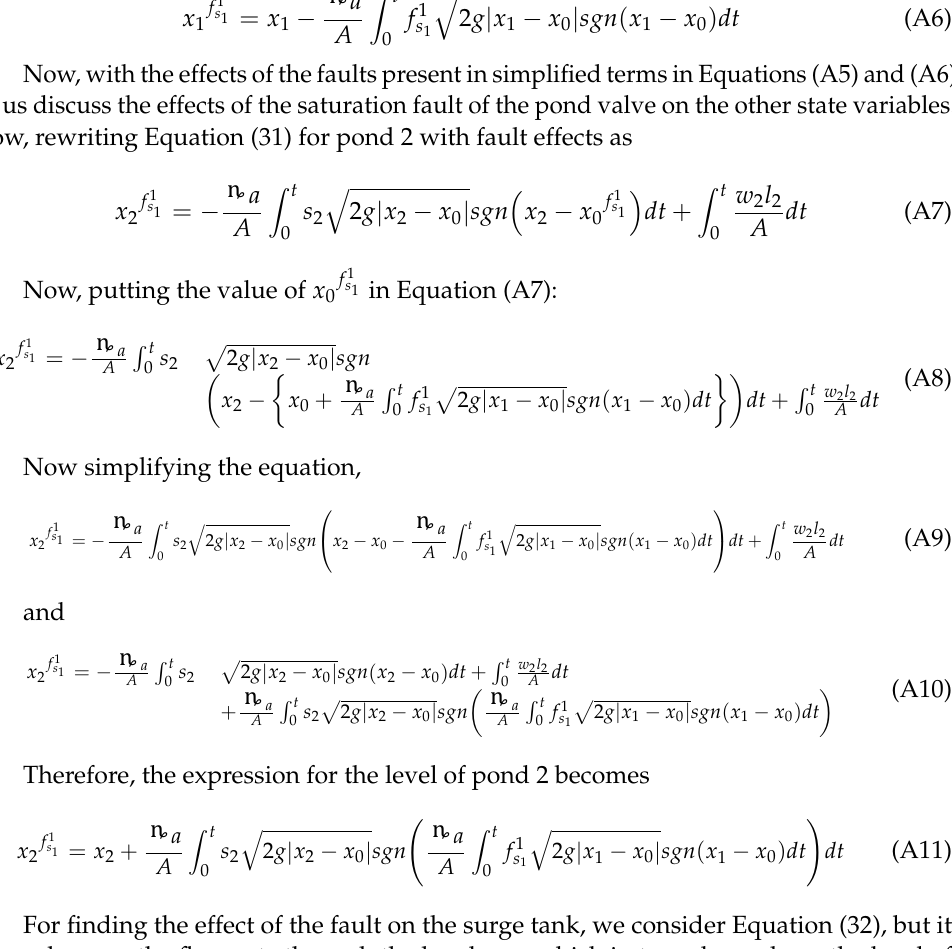
Figure 1. Three-pond hydraulic system.